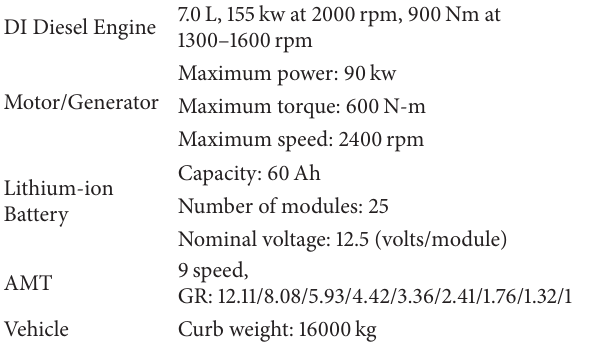
Table 1: Parameters of the hybrid electric